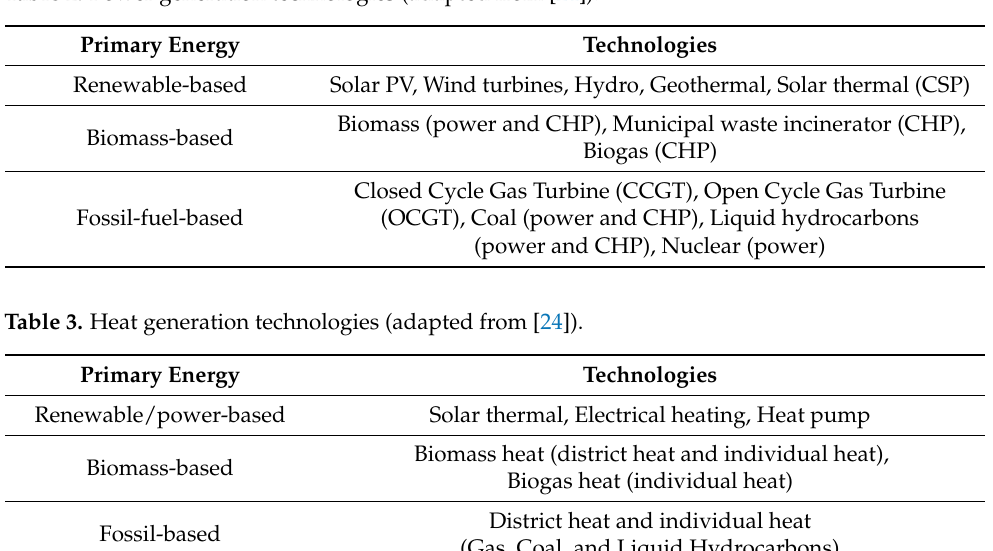
Table 2. Power generation technologies (adapted from [24]).